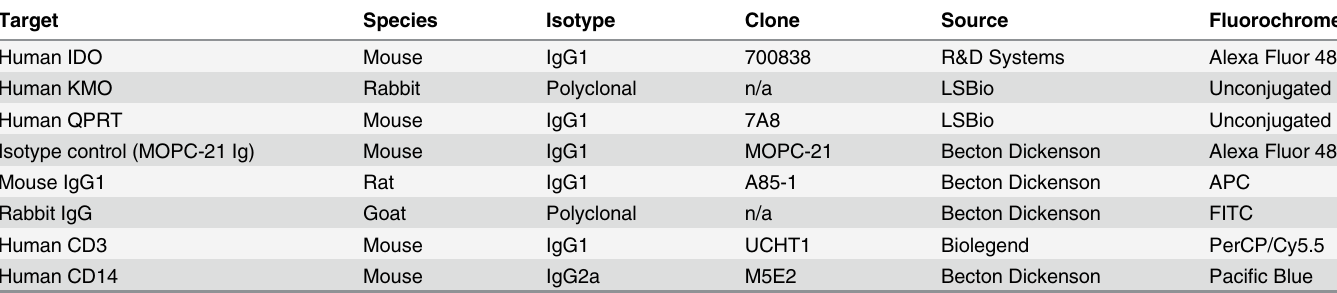
Table 1. Antibodies used in flow cytometry experiments.